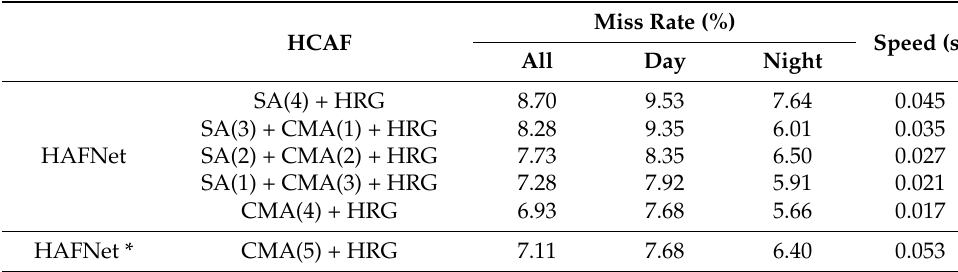
Table 5. Ablation on the quantity of correlation-modality attention (CMA) blocks. The HAFNet utilizes feature maps from the feature extraction module in stages 2 to 5.